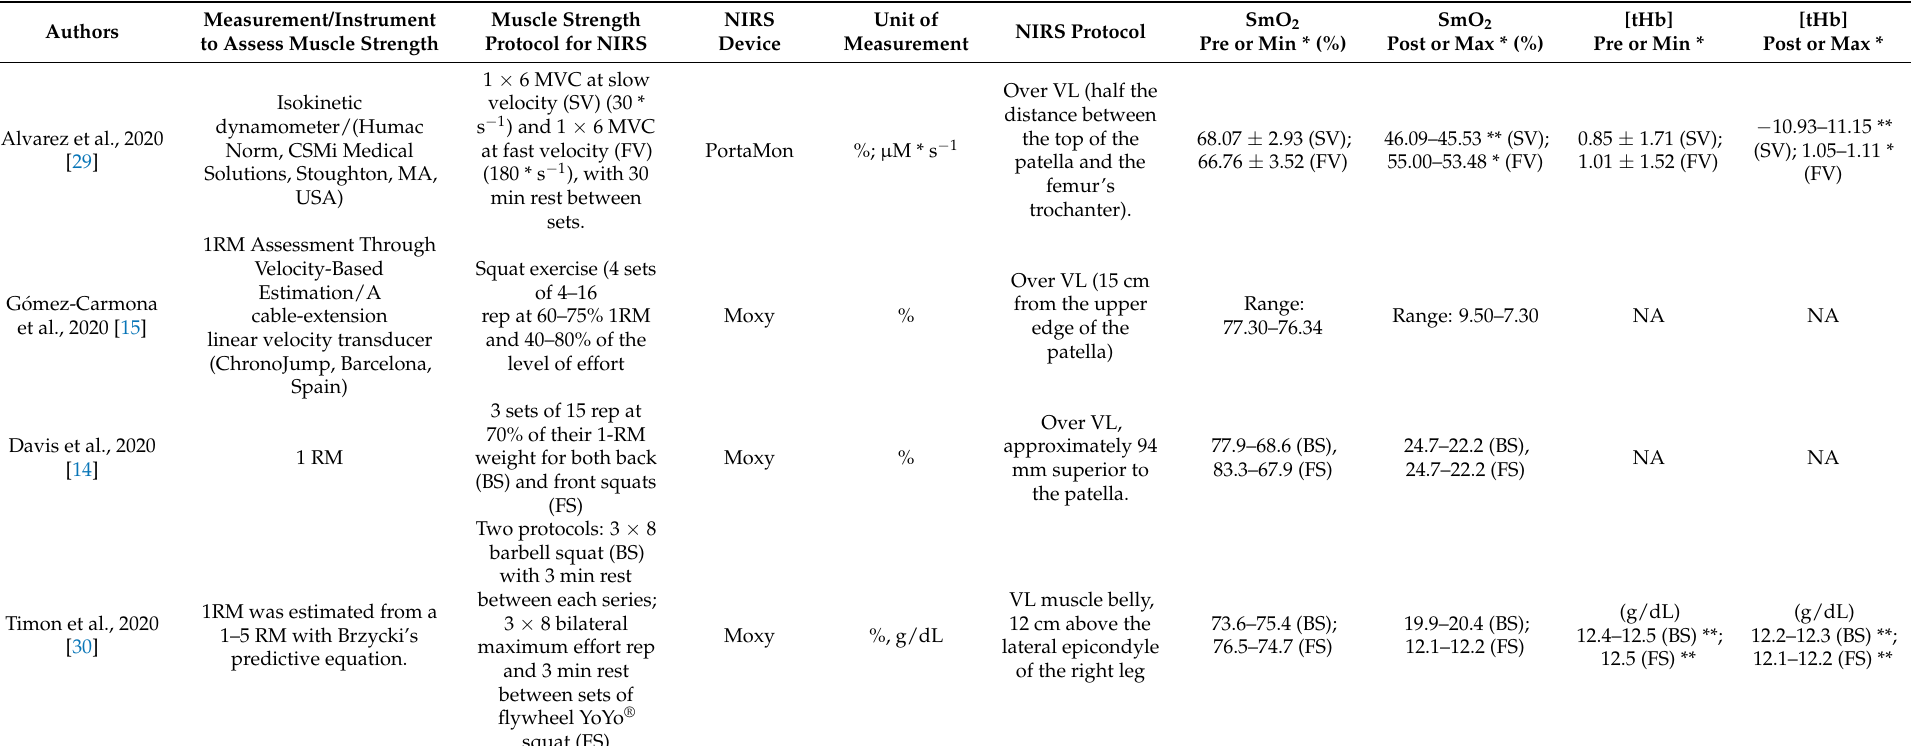
Table 4. Summary of findings from studies investigating muscle oxygen saturation before and after muscle strength